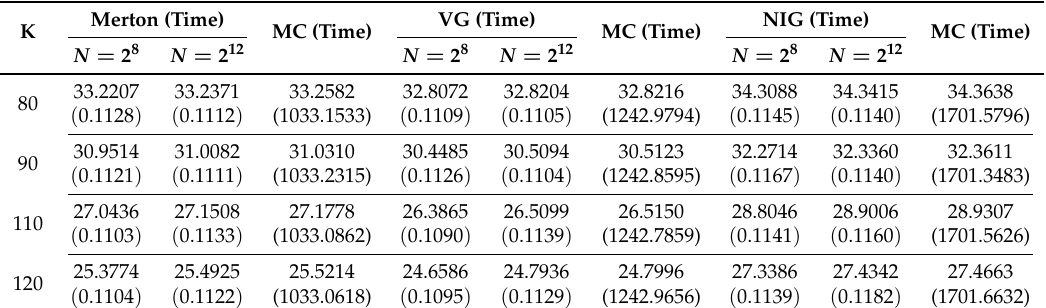
Table 6. Approximation results for finite GMDB, where X is Merton, VG, or NIG, b ( s ) = ( s − K ) + and T = 20.